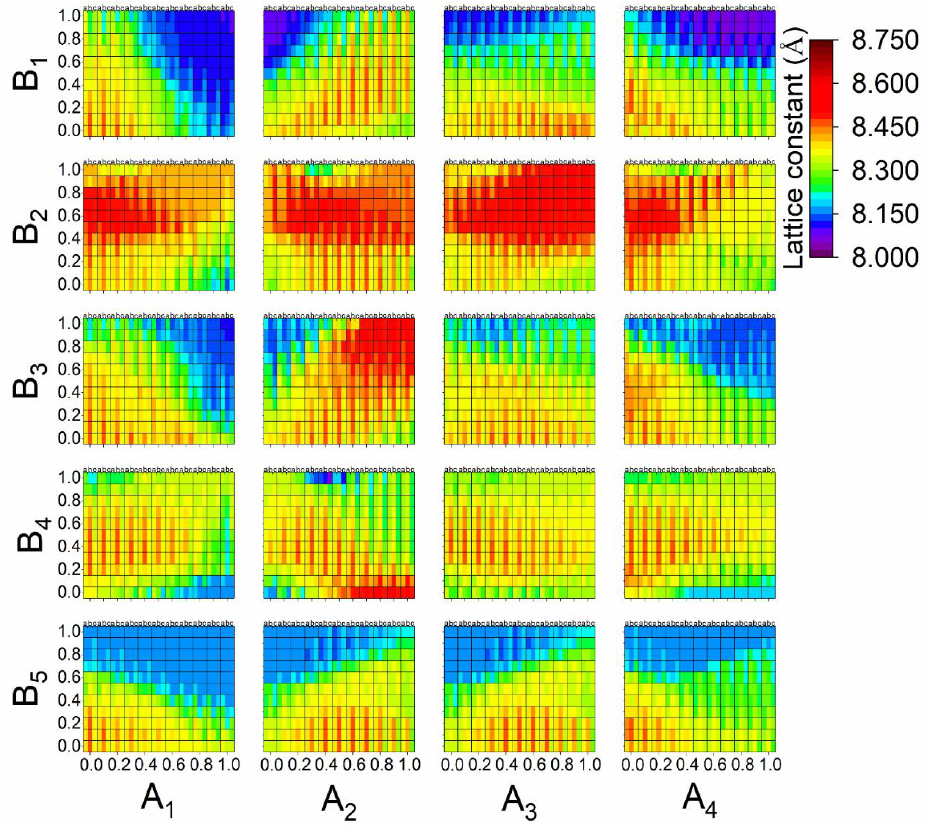
Figure 3. The predicted lattice constants of the spinel-structured HEOx with different proportions of metal cations in the A and B sites.